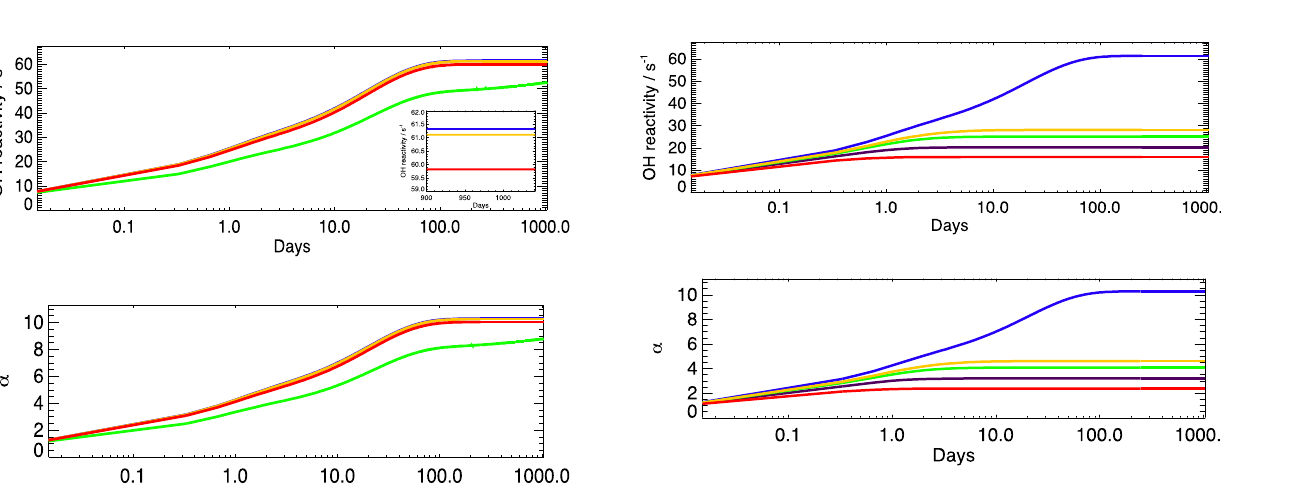
Figure 7: Evolution of total OH reactivity and α in the base simulation with constant zero HO 2 concentration (dark blue) and a simulation with a HO 2 concentration of 2.5 × 10 8 molecule cm -3 (green). This increase in both reactivity and α is due to the formation of peroxides that can catalytically destroy OH as described in the text. The reactivity due to the peroxides alone is shown in the yellow trace. 4.3. Photolysis and other oxidants The evolution of the system’s OH reactivity is also found to be impacted by the introduction of photolysis and oxidants other than OH into the modelling system. Figure 8 shows the impact of both other oxidants and photolysis on the system. For the photolysis we use a constant photolysis rate calculated at the appropriate rates for a solar zenith angle of 45  , and an O 3 column of 260 Dobson units. This reduces the reactivity in the system and α by